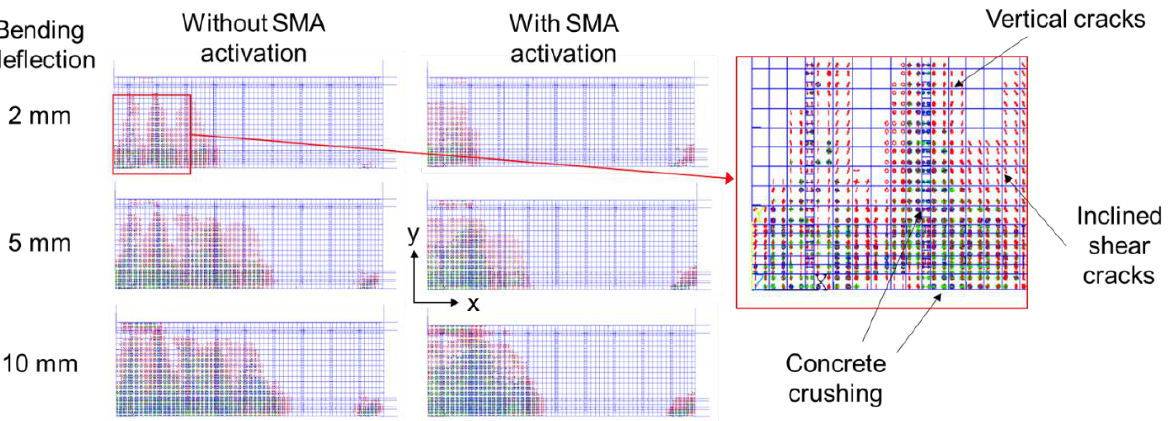
Figure 6. Cracking and crushing patterns developed in FE simulation of bending of the RC beam on x-y plane, for RC beams with 5 Fe-SMA bars with and without activation.